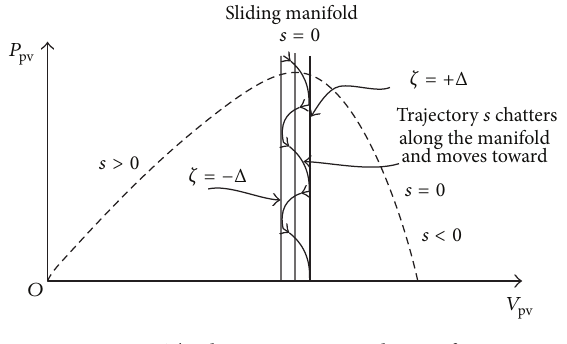
Figure 7: The dynamic accommodation of 𝑉